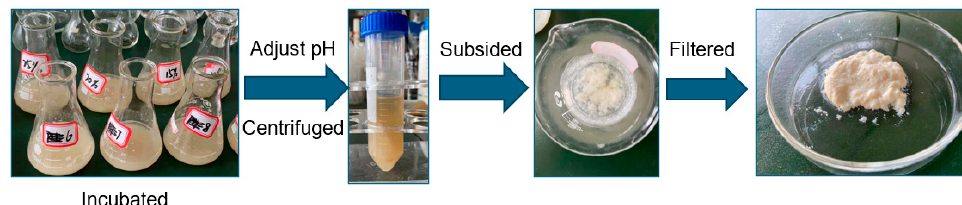
Figure 7. Schematic of the extraction of pig nail keratin.